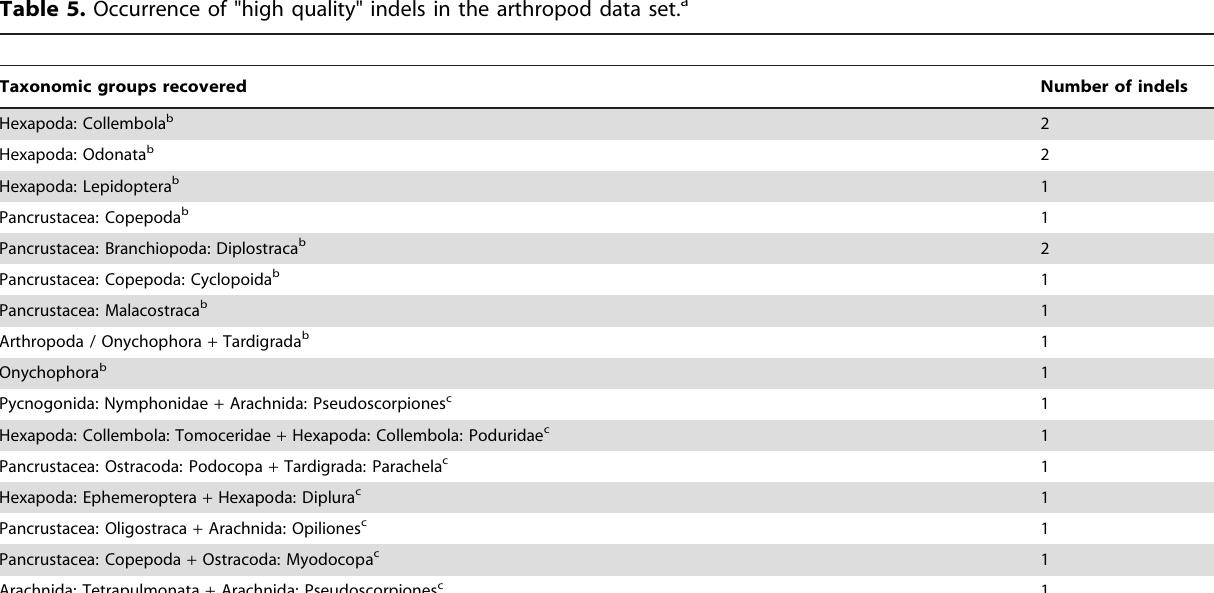
Table 5. Occurrence of "high quality" indels in the arthropod data set. a